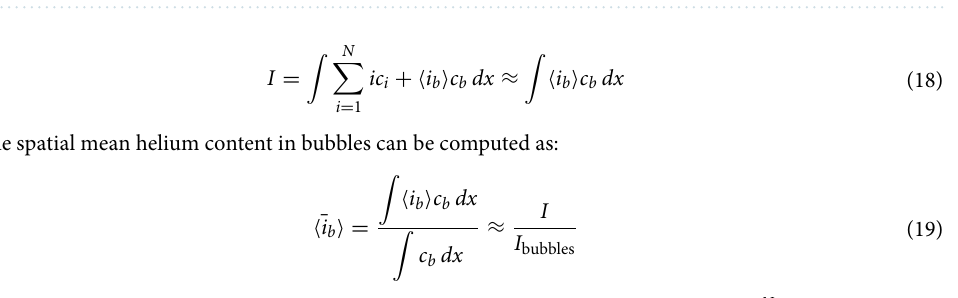
Figure 6. Evolution of quantities as a function of the implanted flux and temperature after 1 h of 100 eV He exposure. Grey crosses correspond to simulations